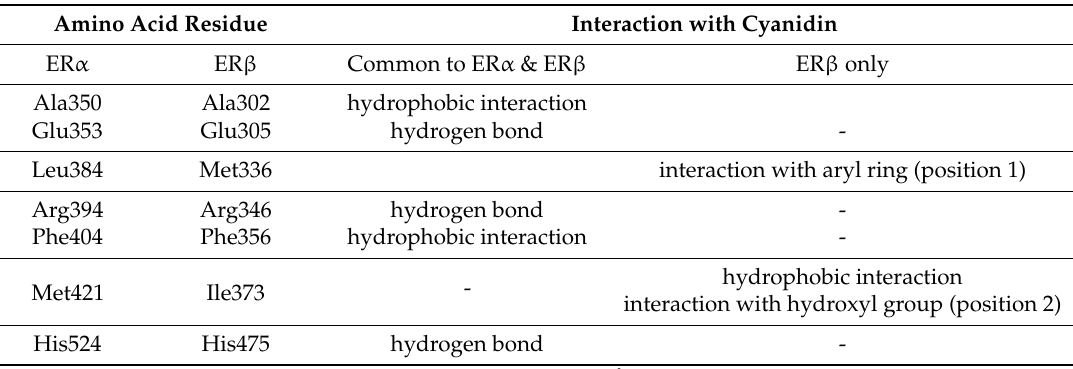
Figure 7. Difference in binding affinity of cyanidin to ER α and ER β . Hydrogen bonds of each compound and ERs are indicated as blue dotted lines. Red, blue, and black circles indicate position 1, position 2, and aryl ring, respectively. Red arrows indicate hydroxyl groups. ( a ) Interaction of cyanidin with ER α ; ( b ) cyanidin with ER β ; ( c ) genistein with ER α ; and ( d ) genistein with ER β . Table 1. Comparison of predicted interactions between cyanidin and ER α or ER β .